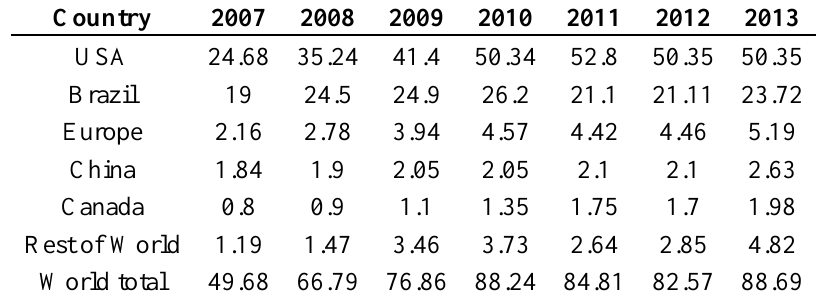
Table 1. Global ethanol production from 2007 to 2013 by country or region in million m 3